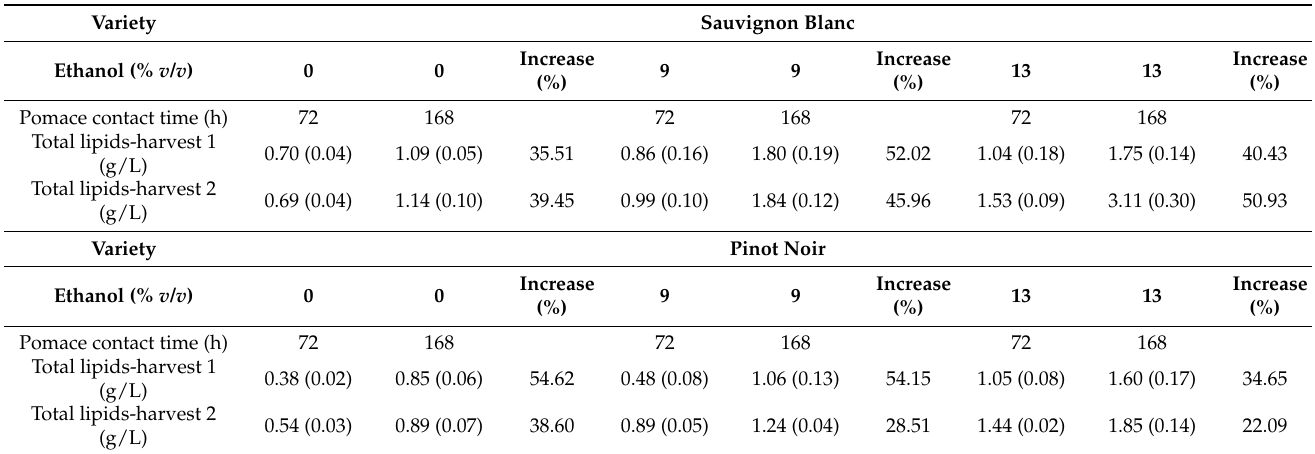
Table 5. Effect of ethanol concentrations on lipid extraction from Sauvignon blanc and Pinot noir grape pomace. Standard deviations are shown within